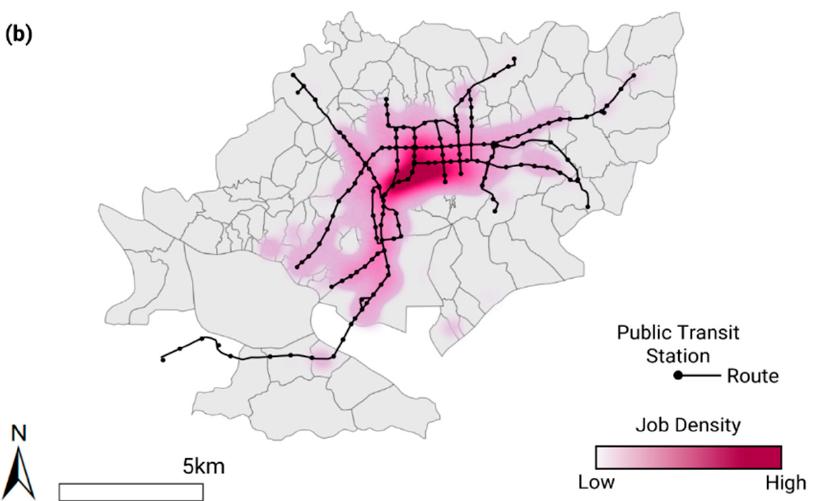
Figure 3. ( a ) The ratio of Korean population to Japanese population at the neighborhood level; ( b ) A kernel density estimation map of 3598 jobs in the study area.